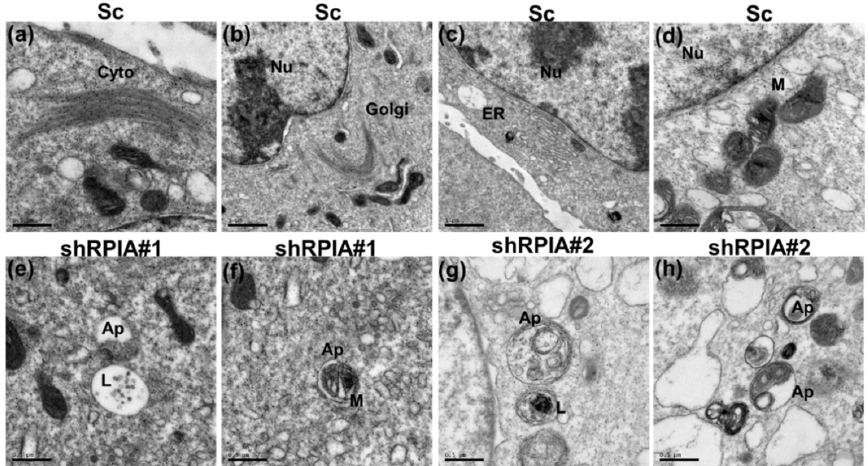
Figure 6. The appearance of autophagosome formation in shRPIA knockdown lung cancer cells by transmission electron microscopy. ( a – d ) Scramble control (sc), ( e , f ) A549 shRPIA#1, ( g , h ) A549 shRPIA#2. Nuclear (Nu), cytoskeleton (Cyto), mitochondria (M), Endoplasmic reticulum (ER), Golgi, autophagosome (Ap), lysosome (L). Magnification ×50000.